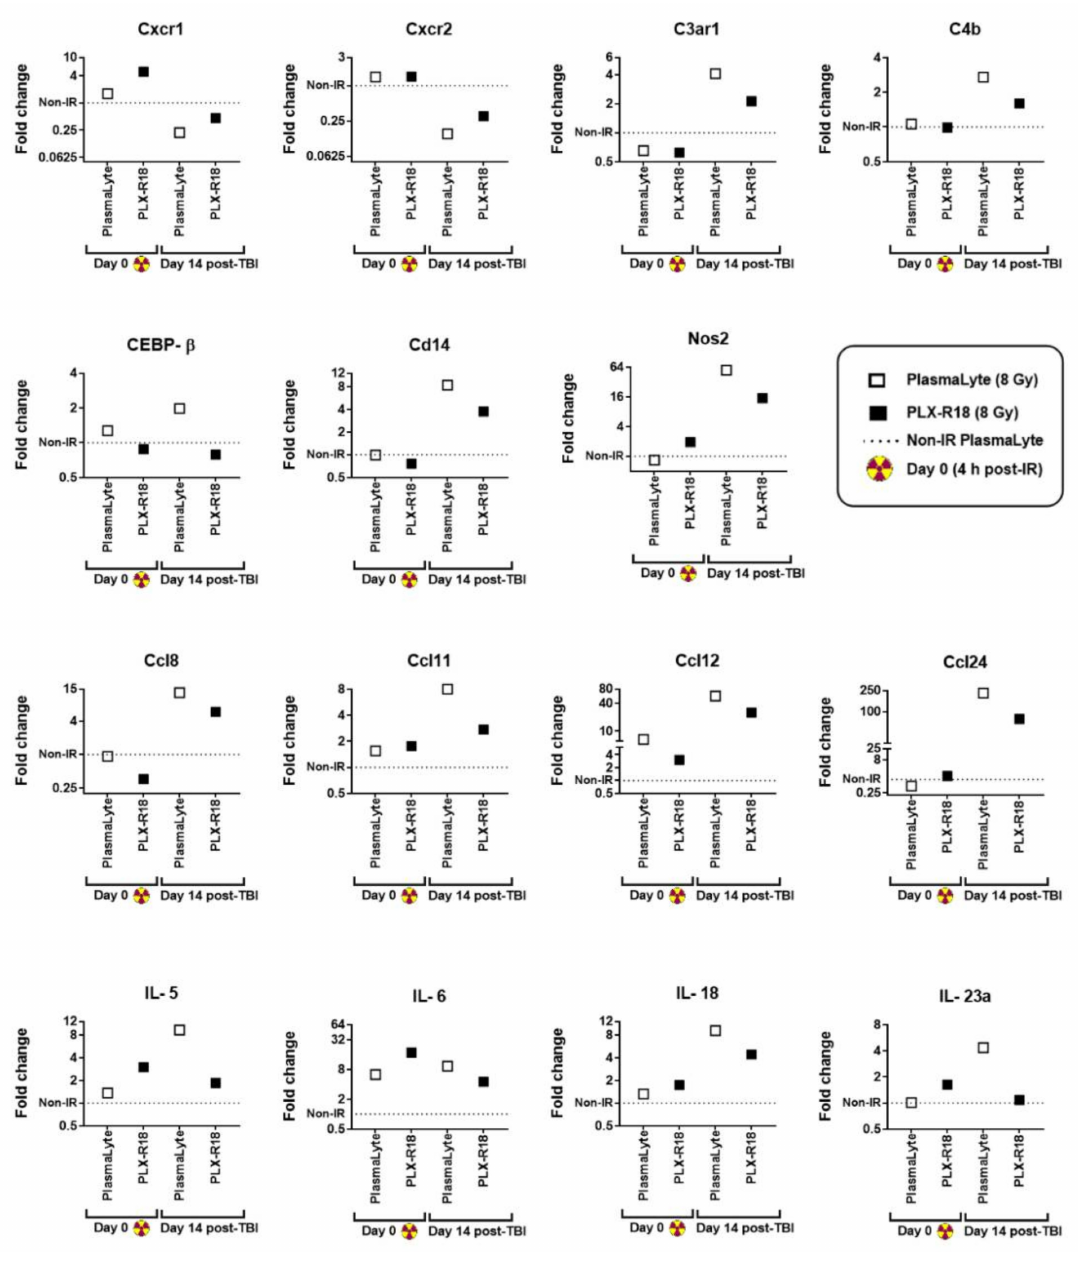
Figure 7. Differential levels of cytokines & receptors from the autoimmune pathway as early and late markers of radiation injury and modulation by PLX-R18 treatment by PCR. Spleen samples were subjected to an array of 42